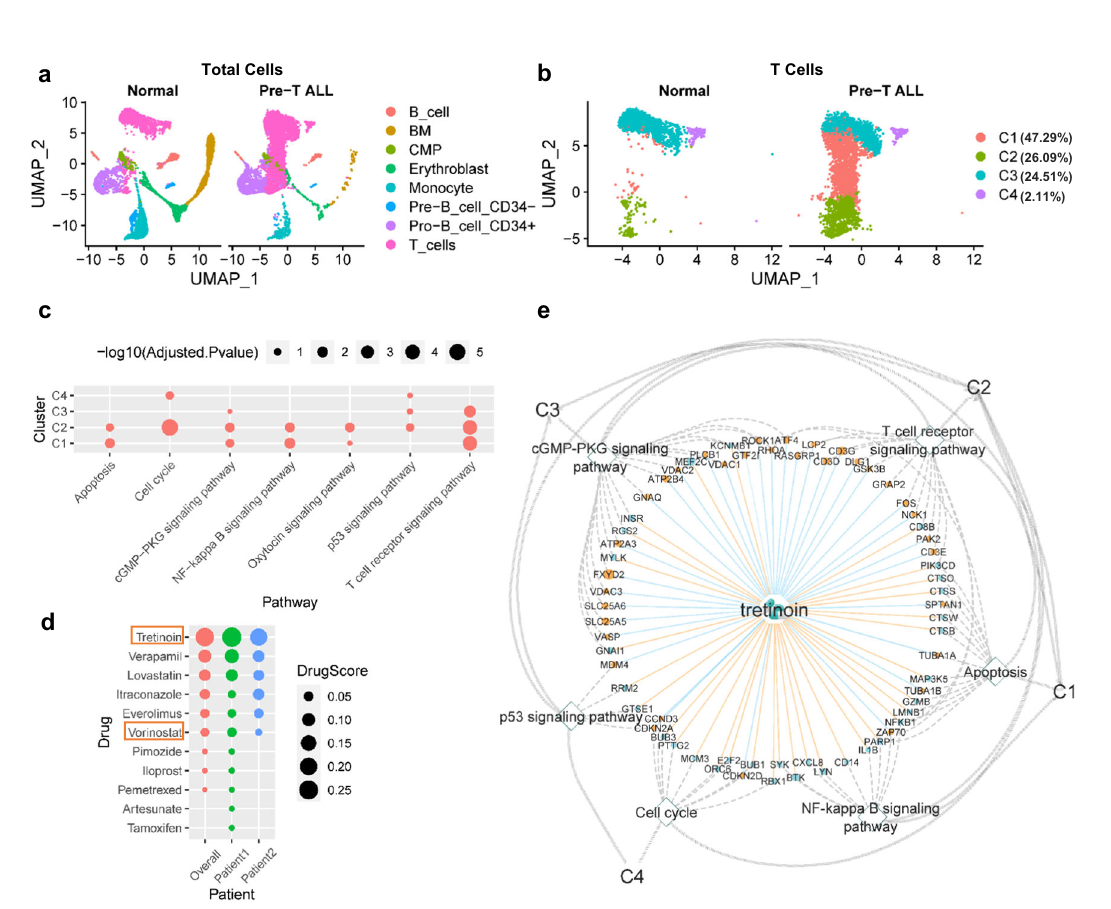
Fig. 5 | Drug repurposing for precursor T cell acute lymphoblastic leukemia (Pre-T ALL). a UMAP plots of all cells from 3 normal controls and 2 Pre-T ALL samples. b UMAP plots of T cell clusters from normal controls and Pre-T ALL samples. c Pathwayenrichmentanalysis(leukemiavsnormal)foreachTcellcluster. P -valuesweredeterminedbytwo-sidedFisher ’ sexacttestandwereadjustedbyBH FDR. d TheoveralldrugscoreanddrugscoreineachPre-TALLpatient,amongtop-